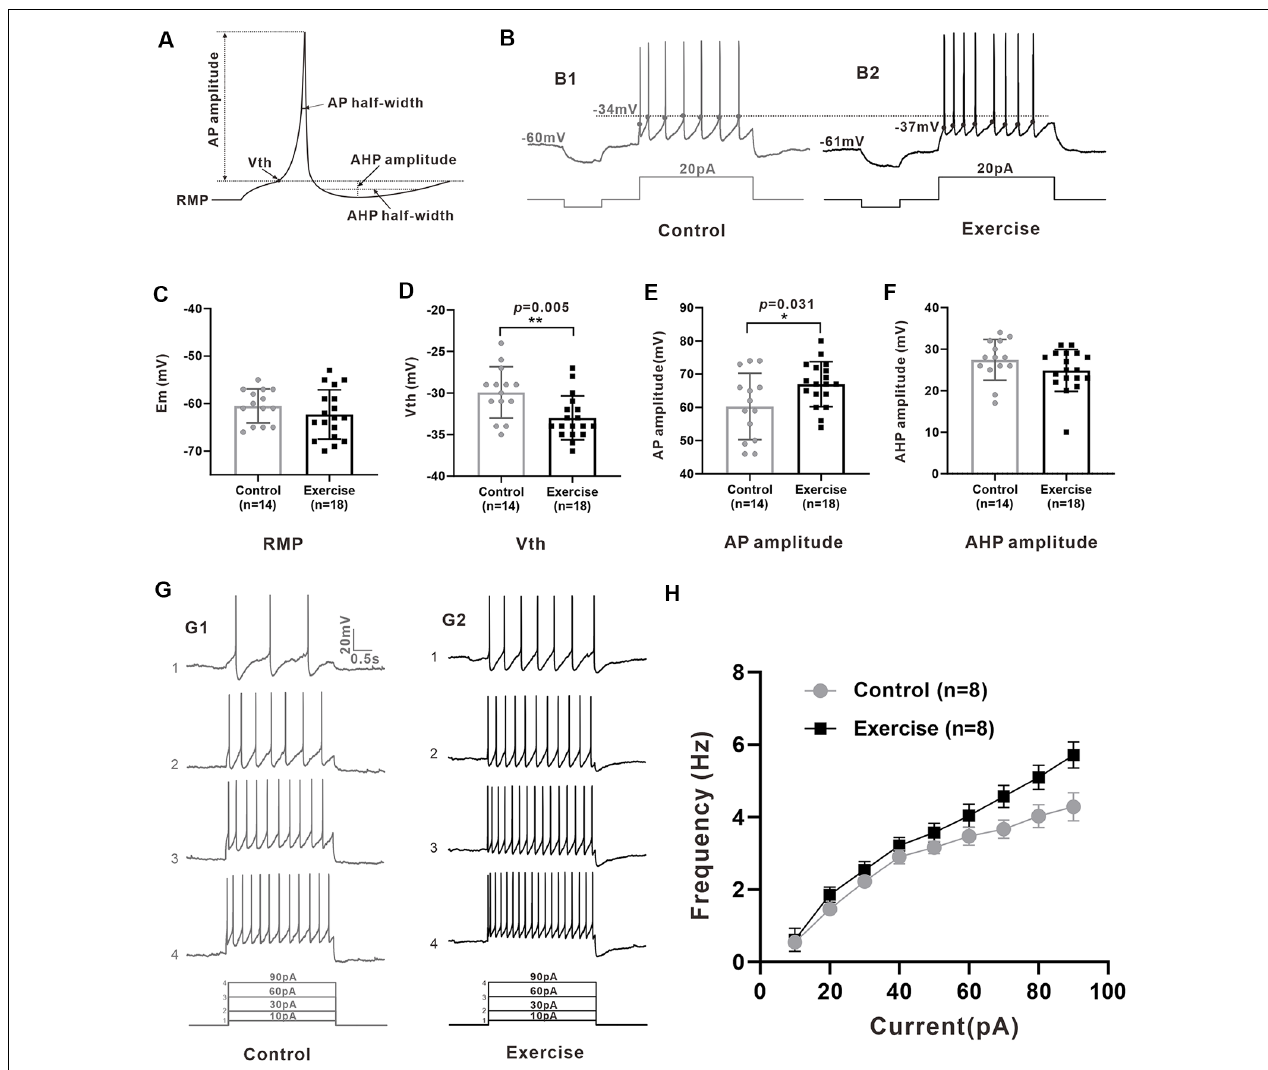
FIGURE 3 | Treadmill exercise increased some measures of excitability of 5-HT neurons. (A) Schematic of calculation of neuron active and passive membrane properties. (B) The voltage threshold of neurons in exercise training group ( B2 , − 37 mV) was hyperpolarized compared with that in the control group ( B1 , − 34 mV). (C) The resting membrane potential (Em) showed a tendency of hyperpolarization after exercise ( p = 0.285). (D) The voltage threshold (Vth) of 5-HT neurons in the exercise group was significantly hyperpolarized than that of the control group ( p = 0.005). (E) The AP amplitude of 5-HT neurons in the exercise group was bigger than that of the control group ( p = 0.031). (F) No significant difference was found in after-hyperpolarization (AHP) amplitude ( p = 0.270). (G) A typical example showed that under the same current input (bottom), the AP frequency of neurons in the exercise group (G1) was significantly higher than that in the control group (G2) . (H) Two-way ANOVA with repeated measures detected a significant main effect of injected currents, with frequency increasing ( F (8,5) = 25.317, p = 0.001). There was no significant effect of exercise training ( F (1,12) = 4.196, p = 0.063) or current × training interaction ( F (8,5) = 4.361, p = 0.061). Mean ± SEM. * p < 0.05, ** p < 0.01.